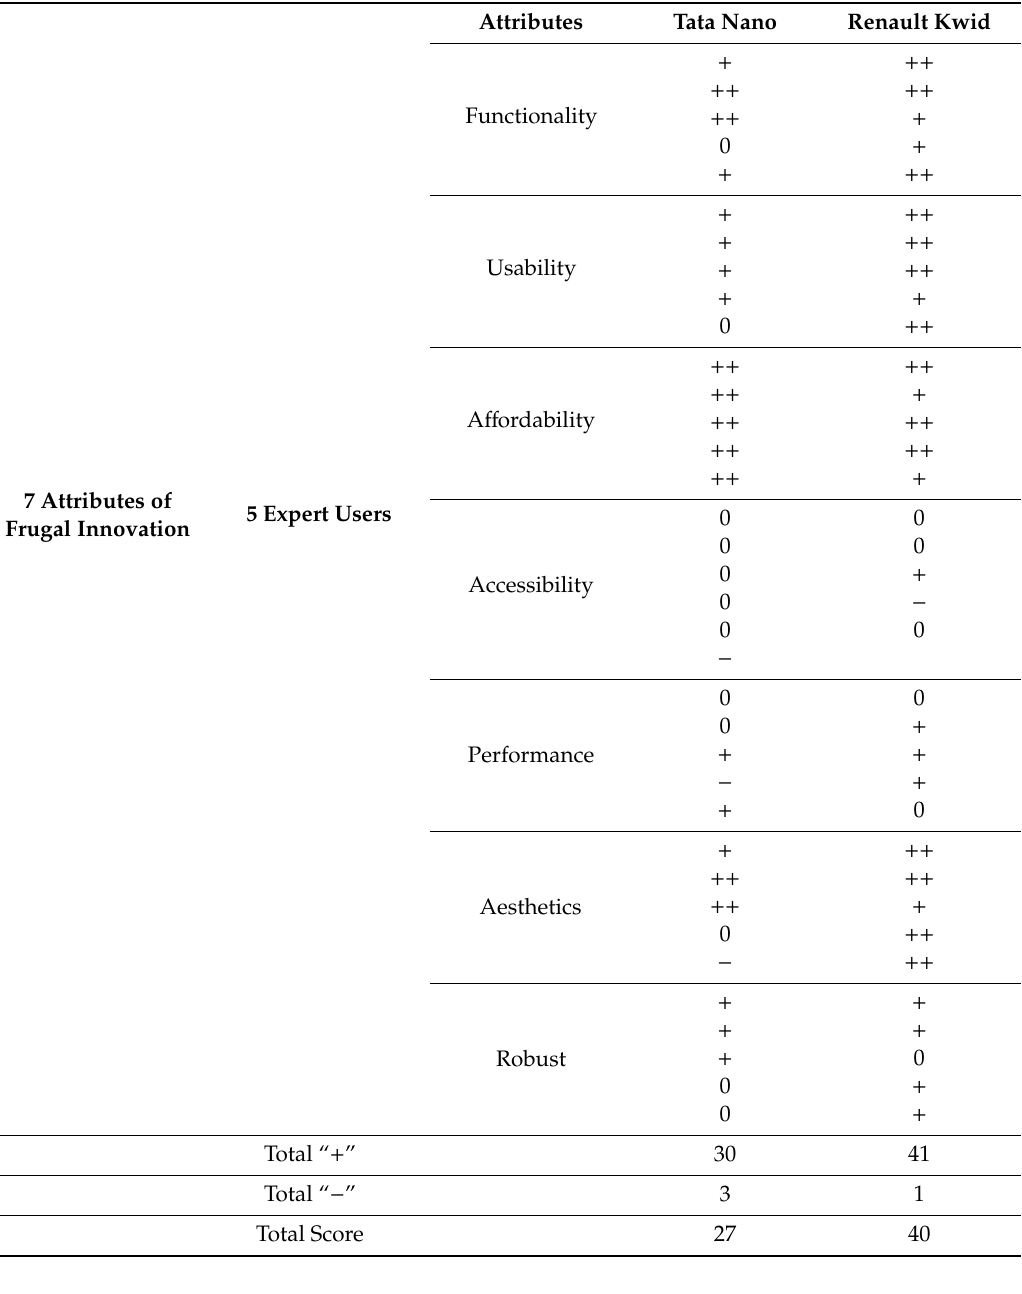
Table 8. Case study (i) TATA Nano, and (ii) Renault